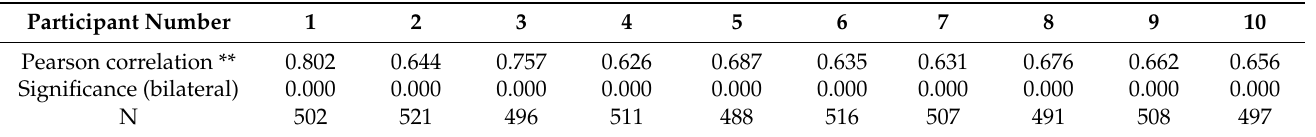
Table 3. Results of Test-retest Reliability Testing of Ten